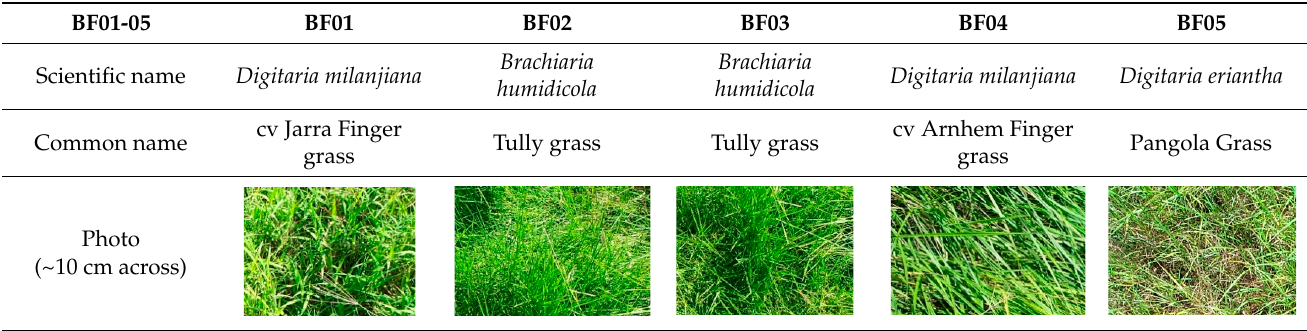
Table 1. Sites BF01-05 of the grasses sampled, scientific, common names and representative